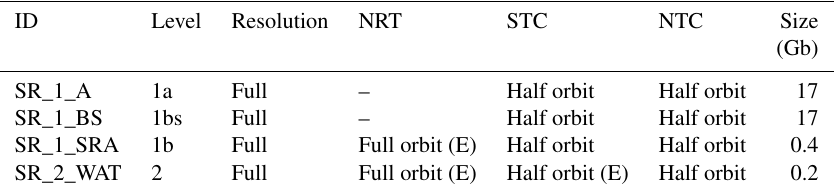
Table 5. Ocean surface topography data products (SRAL). All products are available from the monthly online rolling archive (ODA) and the long-term archive (DC); see Sect. 3. EUMETCast dissemination is indicated by (E). The sizes are given for a full orbit and are an approximation based on compression assumptions. The SR_1_A and SR_1_BS products are in development, and the product sizes are a rough